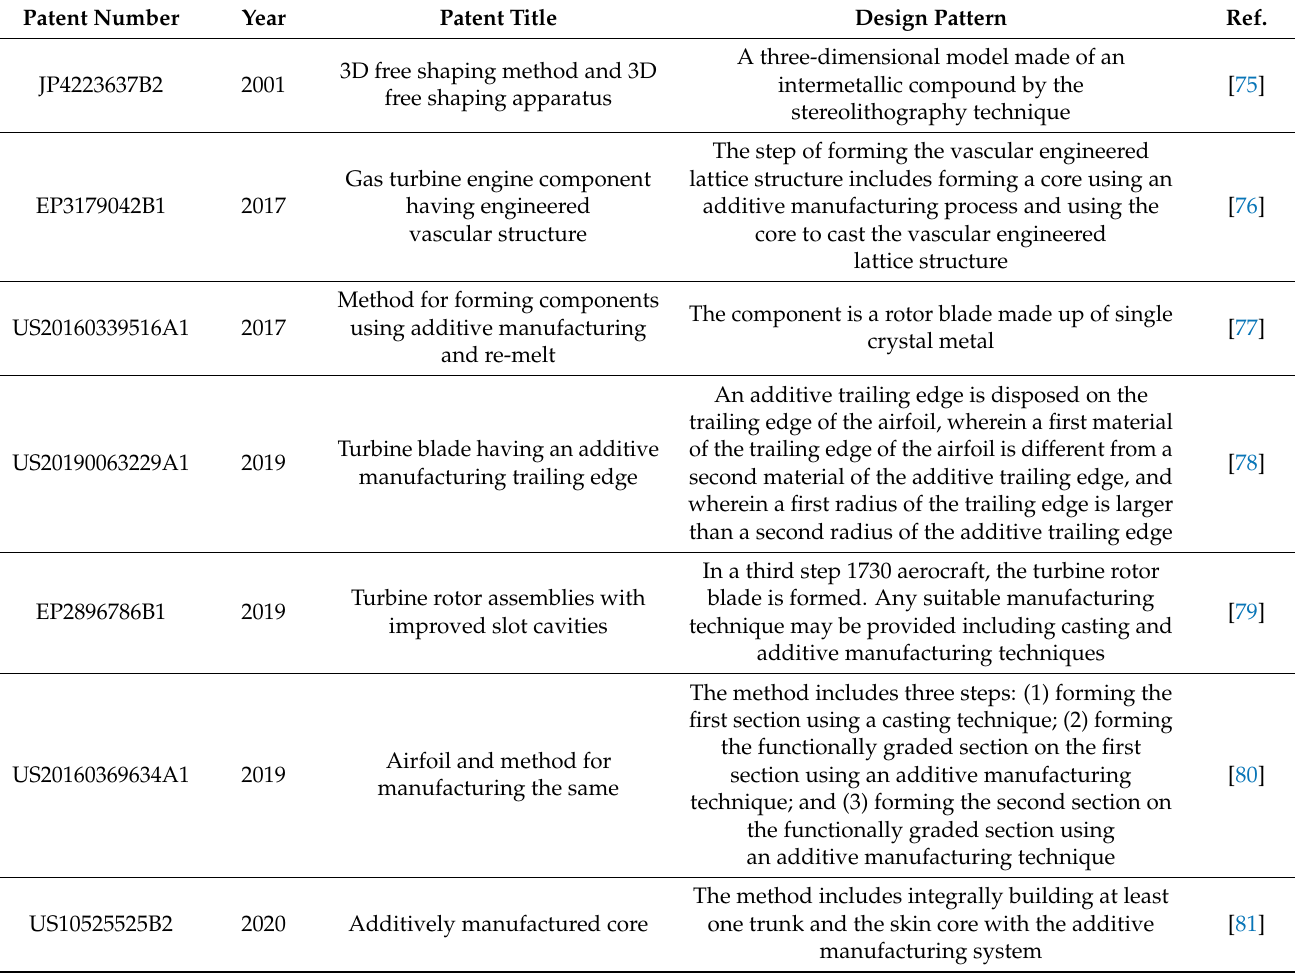
Table 2. Patents based on additive manufacturing in turbine